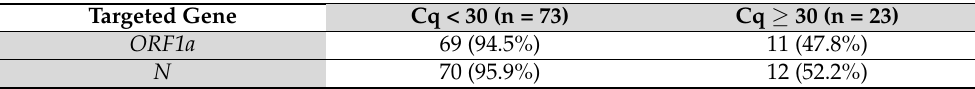
Figure 9. RT-LAMP assay on clinical RNA samples using primer targeting B region on the N gene. ( A ) The reaction results after incubation in a heat block at 65 °C for 30 min, in which the pink color indicated a negative reaction, while the yellow color denoted a positive reaction. ( B ) A table summarizing the RT-LAMP assay on the B target of the N gene. All positive samples with Cq values of <30 (n = 73) were detectable by 95.9% for the N gene using the RT-LAMP. The samples with Cq values of >30 were less sensitive to be detected by the RT-LAMP (52.2%). Table 2. Data analysis from RT-LAMP on clinical RNA samples. The RT-LAMP was performed on the primer target B region of ORF1a and N genes. The newly developed RT-LAMP assay obtained comparable sensitivity to the RT-PCR assay. All positive samples with Cq < 30 values (n = 73) were detectable by 94.5% for the ORF1a gene and 95.9% for the N gene. The samples with Cq values > 30 designated either inconclusive or negative were less sensitive to RT-LAMP detection.